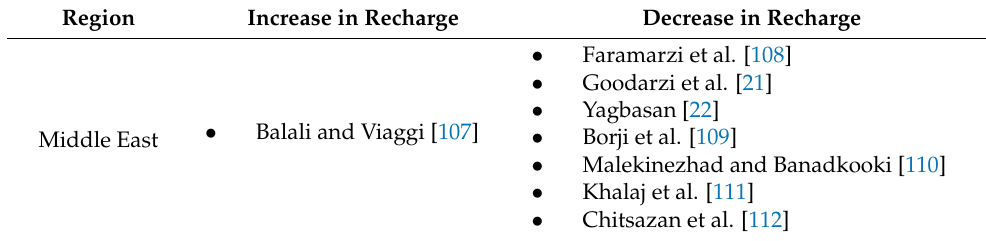
Table 5. Scientific production identified for the Middle East.